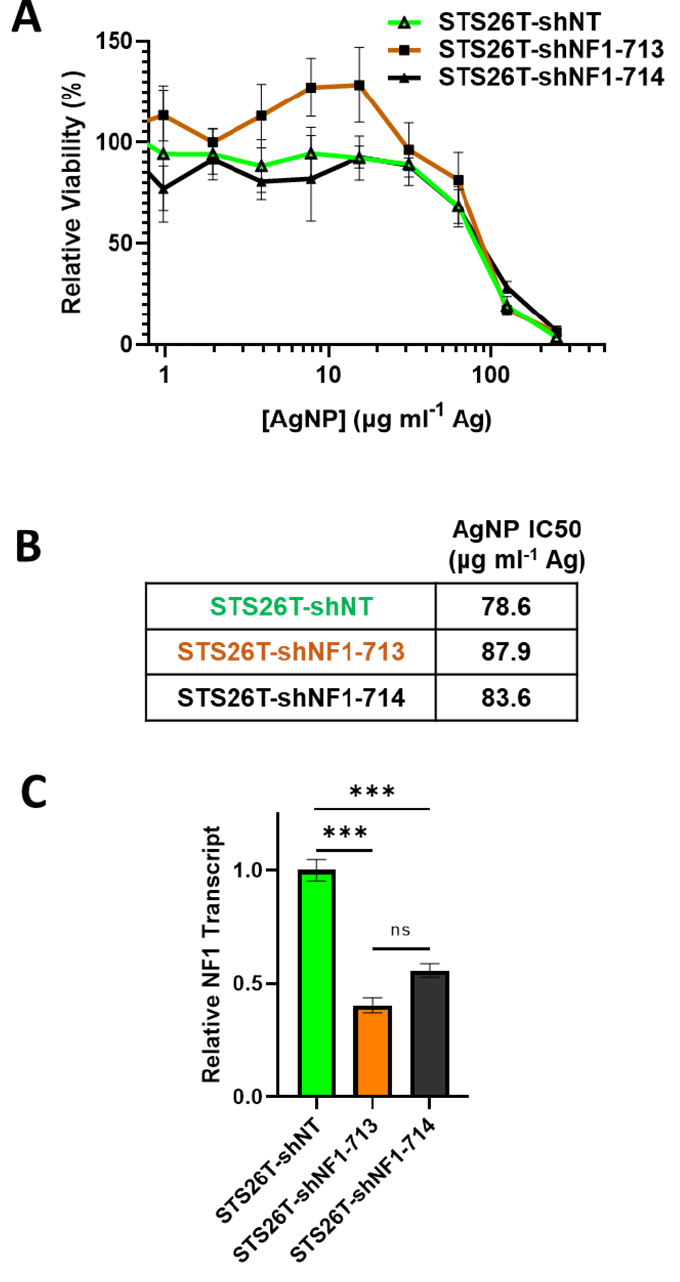
Figure 5. Knockdown of neurofibromin does not alter sensitivity to AgNPs in sporadic MPNSTs . Sporadic MPNST cells (STS26T) were transduced with non-targeting control shNT or shNF1 (713 or 714) and puromycin selected. ( A ) STS26T-shNT, -shNF1-713, and -shNF1-714 were treated with AgNP (0– 250 μ g mL − 1 Ag) for 72 h, and viability was assessed by MTT assay. ( B ) AgNP IC is shown as μ g mL − 1 Ag. ( C ) qPCR specific for NF1 and the housekeeping 50 gene TBP was performed in quadruplicate, and relative neurofibromin transcript levels ± SD calculated using ΔΔ CT methods are shown. Data are representative of 3 independent experiments, each containing 4 technical replicates. *** p < 0.001, n/s p > 0.05. In NF1 patients, peripheral nerve sheath tumors develop after the complete loss of functional NF1 in normal Schwann cells. Based on the finding that the restoration of functional NF1 decreases sensitivity to AgNPs, we sought to investigate whether the reduction of neurofibromin expression would increase sensitivity to AgNPs in tumor cells of the Schwann origin cells. Knockdown of neurofibromin expression was performed, as described above,